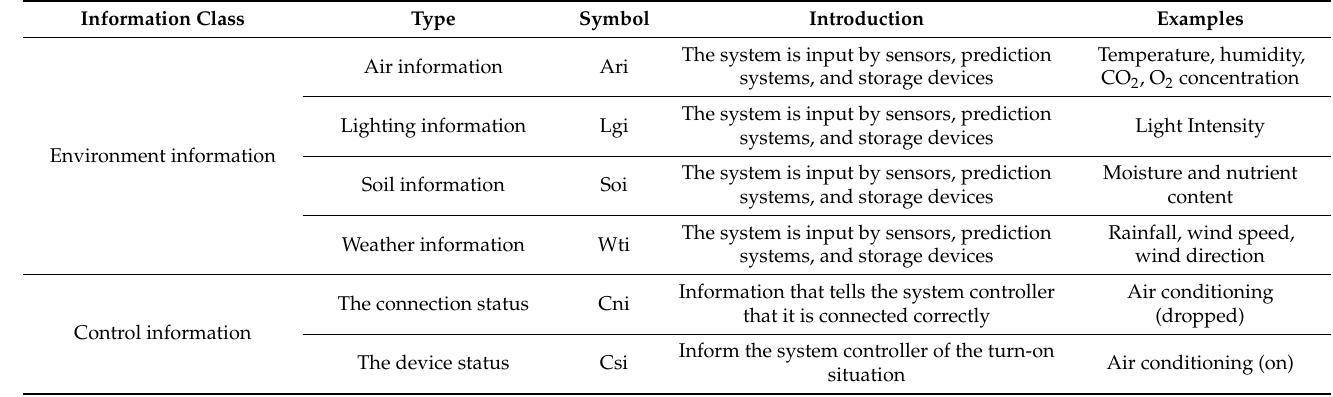
Table 1. Input information